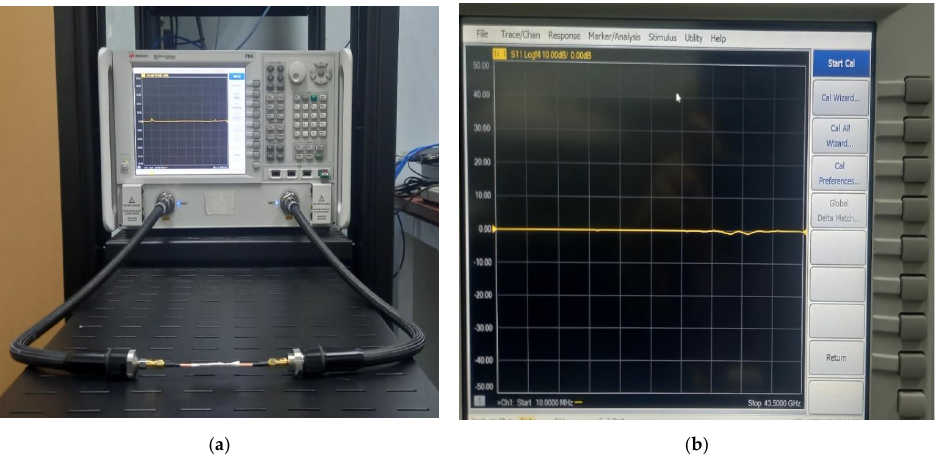
Figure 21. Transmission calibration configuration for two ports: ( a ) reference cable and ( b ) reference value.